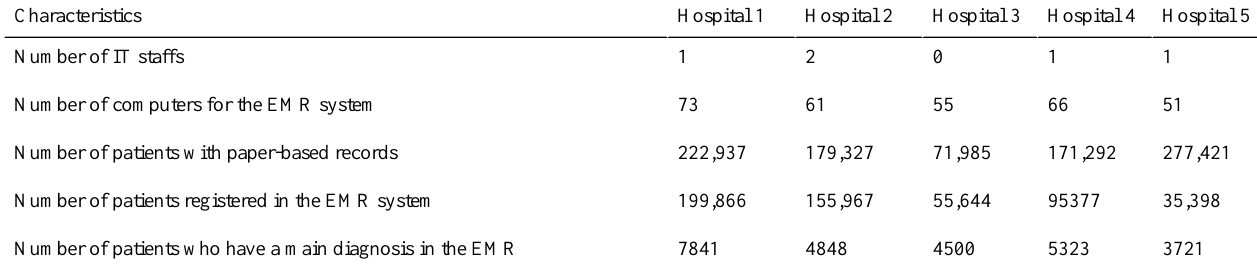
Table 3. Information technology (IT) professionals, reported number of EMR-dedicated computers, and patient records the Addis Ababa study hospitals from January-February, 2014. Most of the information available in the paper-based record system was not registered on the computer. Patient registration in the card room was done by data clerks while the main diagnosis was written by physicians or nursing